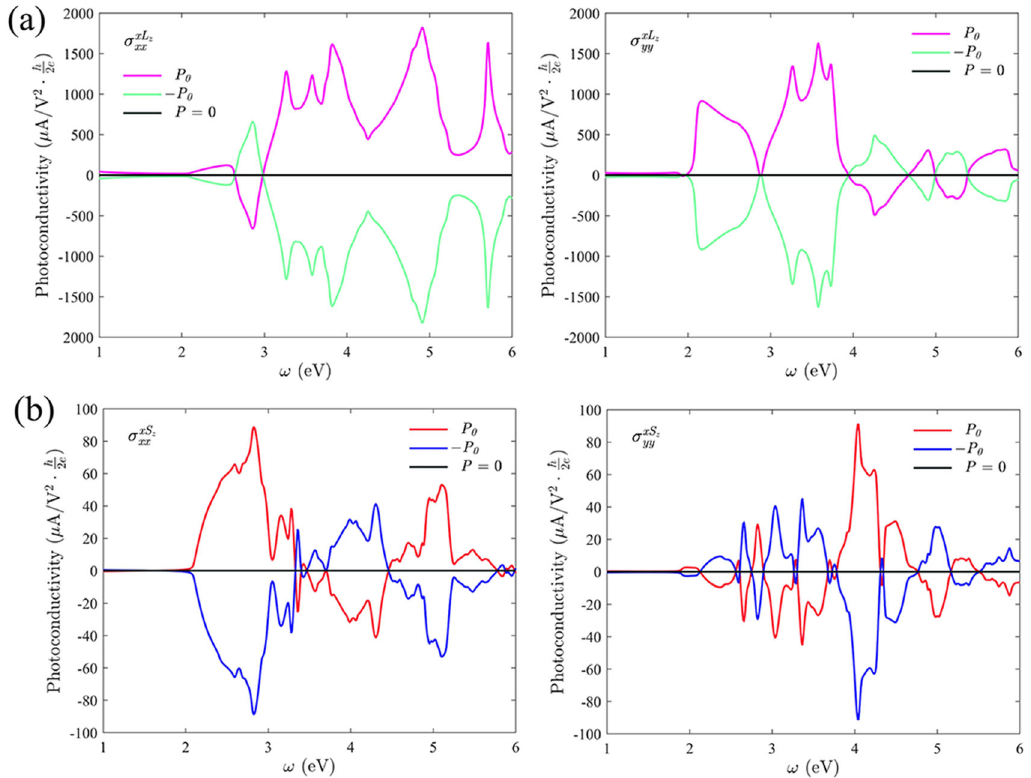
Fig. 5 Polarization effect. Polarization dependent a BOPV and b BSPV conductivity of monolayer GeS. The reversal of polarization P fl ips the photocurrent, while the high-symmetric structure ( P ¼ 0 ) forbids any